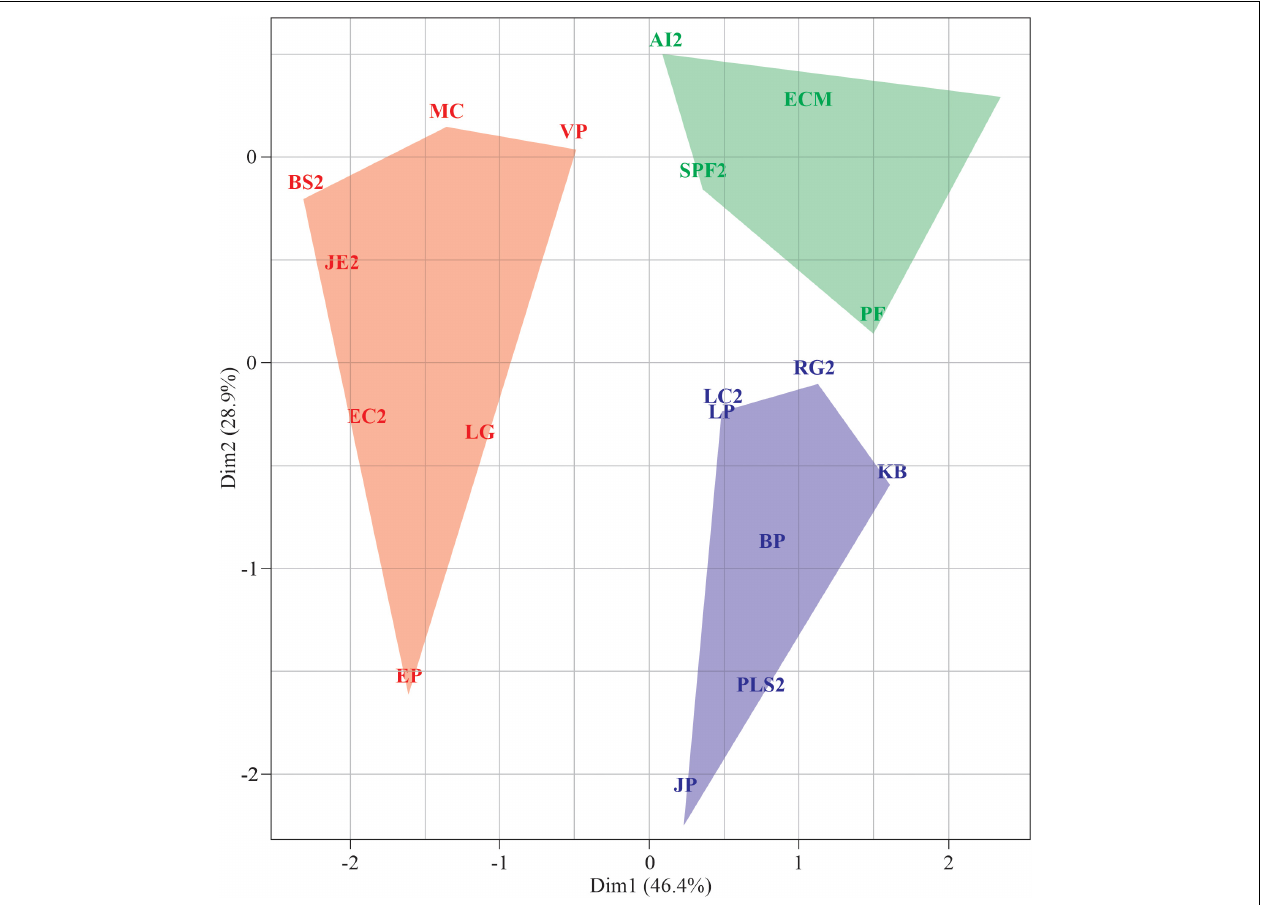
FIGURE 6 | The relation between the plant species phylogenetic relationship and the seed traits. The germination behavior traits were germination with distilled water under white light (G0), relative drought germination (RDG), relative light germination (RLG), and recovery from –0.9 MPa (R0.9). Seed morphology traits were fresh weight of 100 seeds (P100), seed length (SL), and seed shape (SS). The size of the circles corresponds to the magnitude of the mean value inside the measured